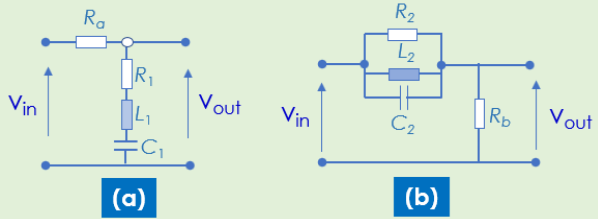
FIGURE 1. (a) RLC-series and (b) RLC-parallel network-based BP-NGD